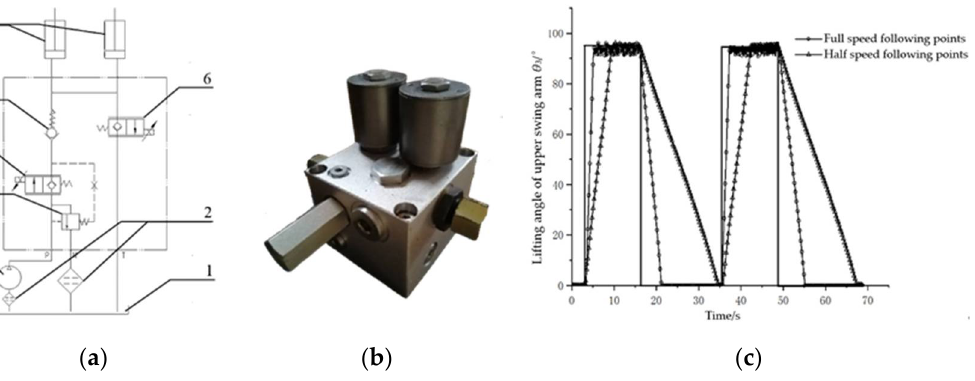
Figure 7. Electronic-control hydraulic lifting system and its lifting tracking tests. ( a ) Schematic of solenoid valve steering; ( b ) Picture of the solenoid valve; ( c ) Results of lifting tracking test. Note: (1) Tank. (2) Filter. (3) Hydraulic pump. (4) Externally controlled relief valve. (5) Spring check valve. (6) Electronically controlled hydraulic steering valve. (7) Hydraulic cylinder.